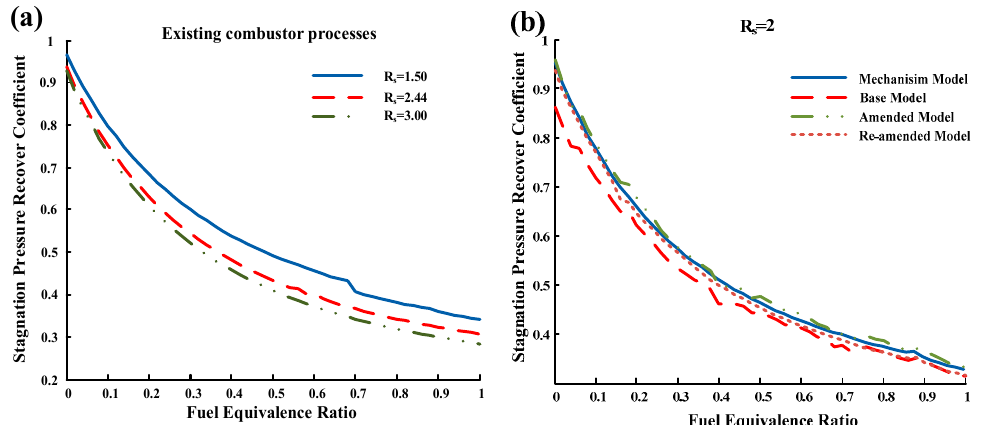
ffi cient. ( a ) existing